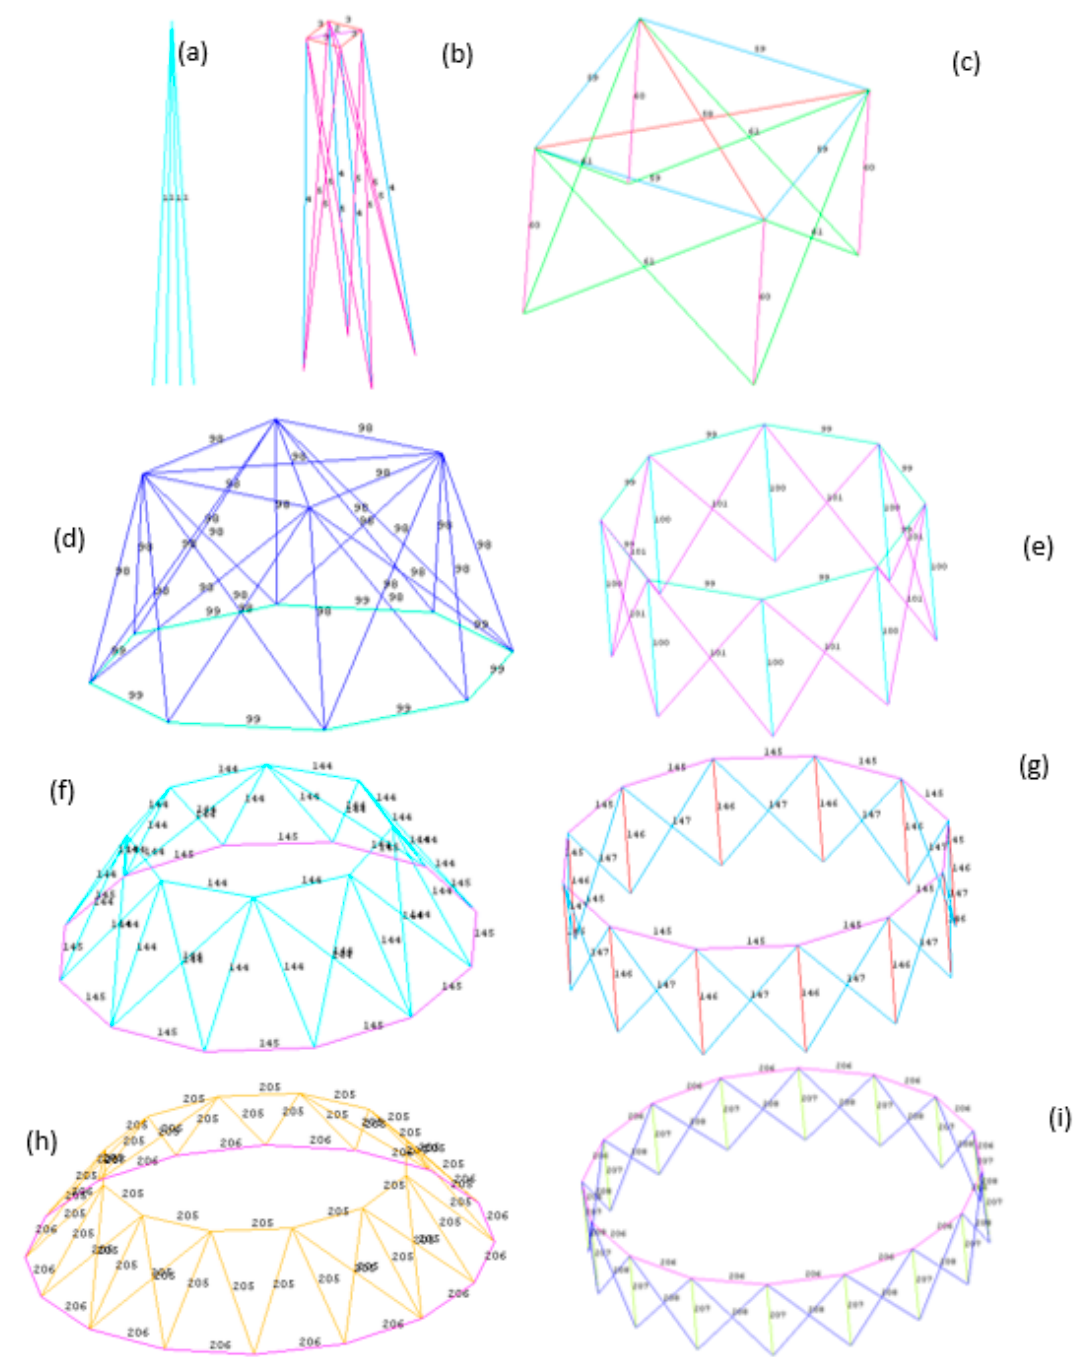
Figure A1. Details of element group numbering for the spatial 3586-bar truss tower: ( a ) Top-level storey of the square-based pyramid segment; ( b ) Second storey from the top of the tower; ( c ) Top-level storey of the square-based prismatic segment; ( d ) Transition from the bottom level-storey of the square-based prismatic segment to the top-level storey of the octagon-based prismatic segment; ( e ) Top-level storey of the octagon-based prismatic segment; ( f ) Transition from the bottom-level storey of the octagon-based prismatic segment to the top-level storey of the dodecagon-based prismatic segment; ( g ) Top-level storey of the dodecagon-based prismatic segment; ( h ) Transition from the bottom-level storey of the dodecagon-based prismatic segment to the top-level storey of the hexadecagon-based prismatic segment; ( i ) Top-level storey of the hexadecagon-based prismatic segment.